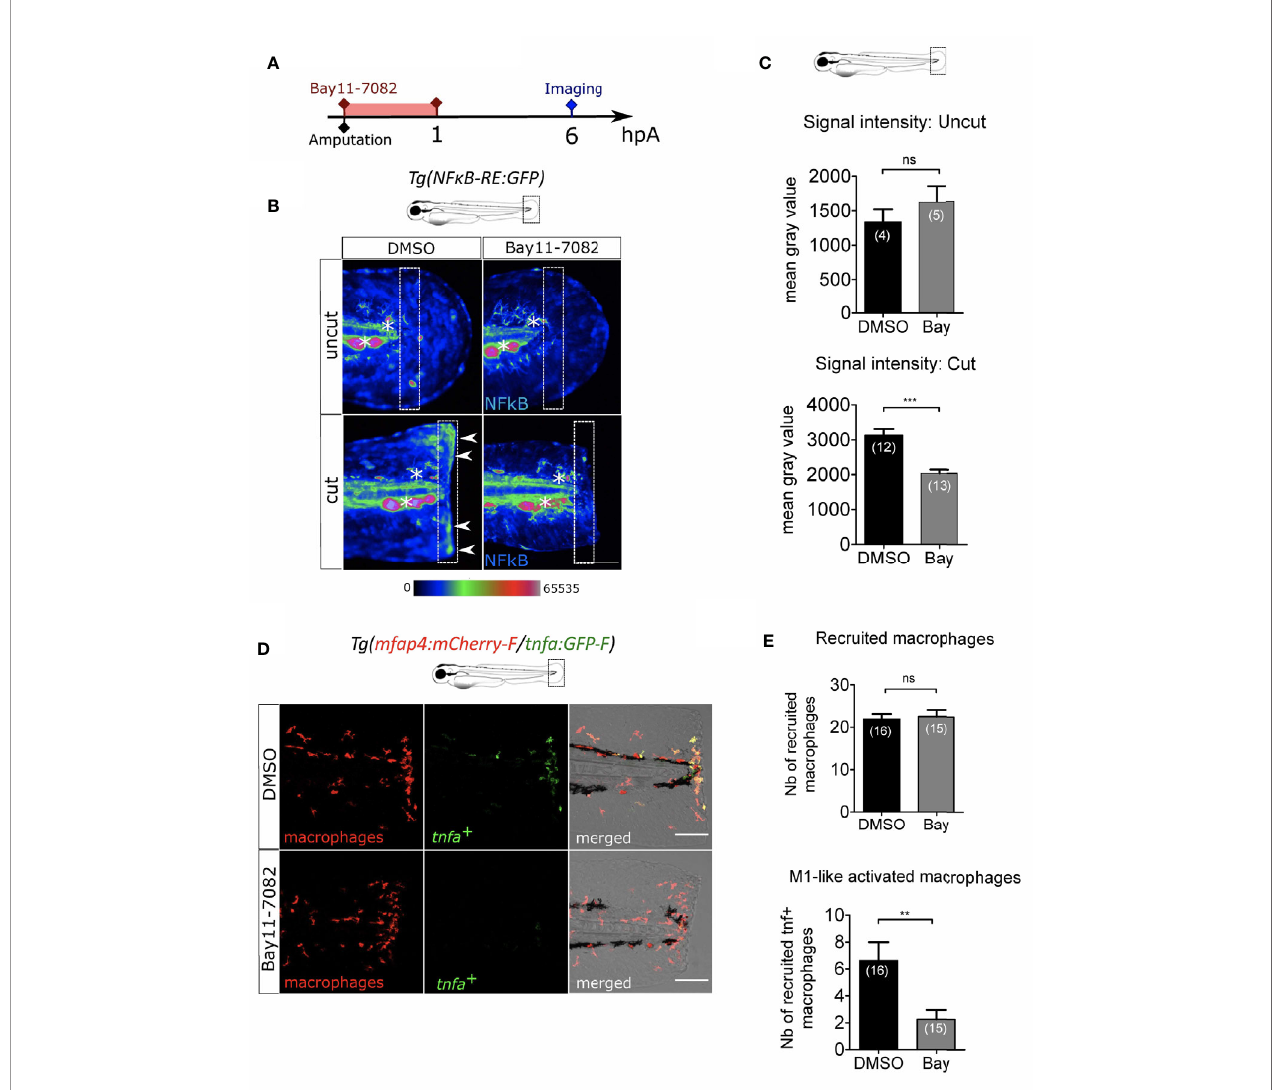
FIGURE 6 | NF k B pathway is enrolled in macrophage activation after wounding. (A) Schedule of the experiment. Fin folds from Tg(NF k B-RE : GFP) or Tg(mfap4: mCh-F/tnfa:GFP-F) were amputated at 3 dpf and immediately treated either with DMSO or Bay11-7082 during 1 h. The drug was removed and larvae were imaged at 6 hpA using epi- fl uorescent or confocal microscopy. (B) Representative images of the GFP fl uorescence in uncut or cut fi n folds from Tg(NF k B-RE : GFP) at 6 hpA, after the treatment with DMSO or Bay11-7082, detecting the NF- k B activation. Rainbow color scale was applied to images, emphasizing the differences in signal intensity. Asterisks show GFP signal in neuromast that is independent on NF- k B signaling. Arrow heads show NF- k B -dependent GFP signal at the wound edge. The white boxes outline the region of quanti fi cation. Scale bar: 100 m m. (C) Quanti fi cation of signal intensity of GFP fl uorescence by mean gray value. Representative experiment of two independent experiments, mean ± SEM, n larvae is indicated in brackets, upper graph: Mann Whitney test, two-tailed, bottom graph: one-tailed t-test, ***p<0.001. (D) Tail images are representative maximum projections of the fl uorescence of mCherry-F (macrophages), GFP-F ( tnfa + cells) and merged channel images with bright fi eld of Tg(mfap4:mCh-F/tnfa:GFP-F) injured larvae after DMSO or Bay11-7082 treatment at 6 hpA. Scale bars: 100 m m. (E) Quanti fi cation of recruited macrophages (up) and tnfa + recruited macrophages (middle) in controls and in DMSO or Bay11-7082 treated larvae at 6 hpA. Representative experiment of three independent experiments, mean ± SEM, n larvae is indicated in brackets, upper graph: two-tailed t-test, ns – not signi fi cant, bottom graph: two-tailed t-test with Welch ’ s correction,